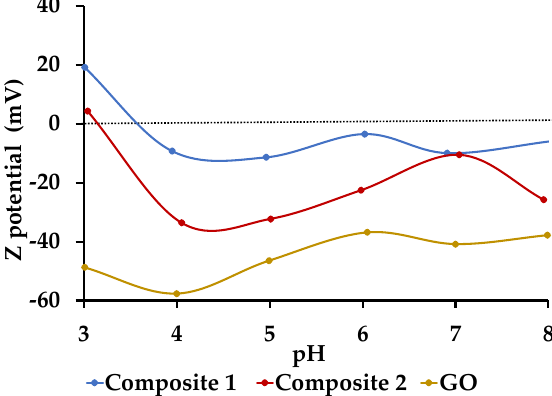
Figure 9. GO and composites surface charge in a pH range between 3 and 8.